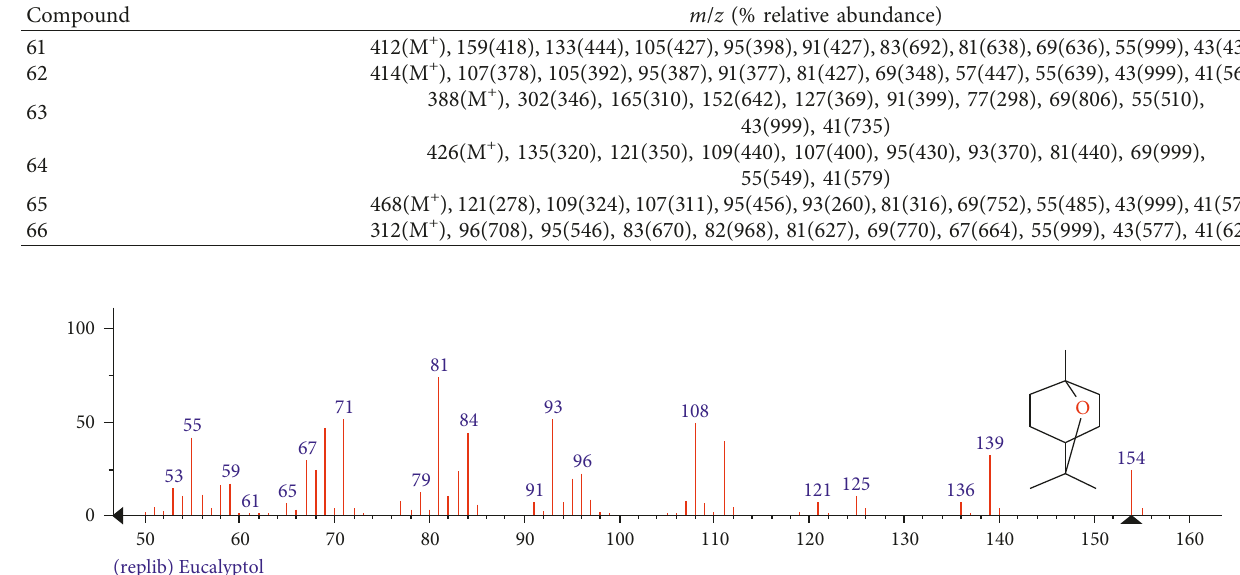
Figure 1: Mass spectrum of compound eucalyptol of whole plant hexane fraction of Achillea wilhelmsii (WHFAW).